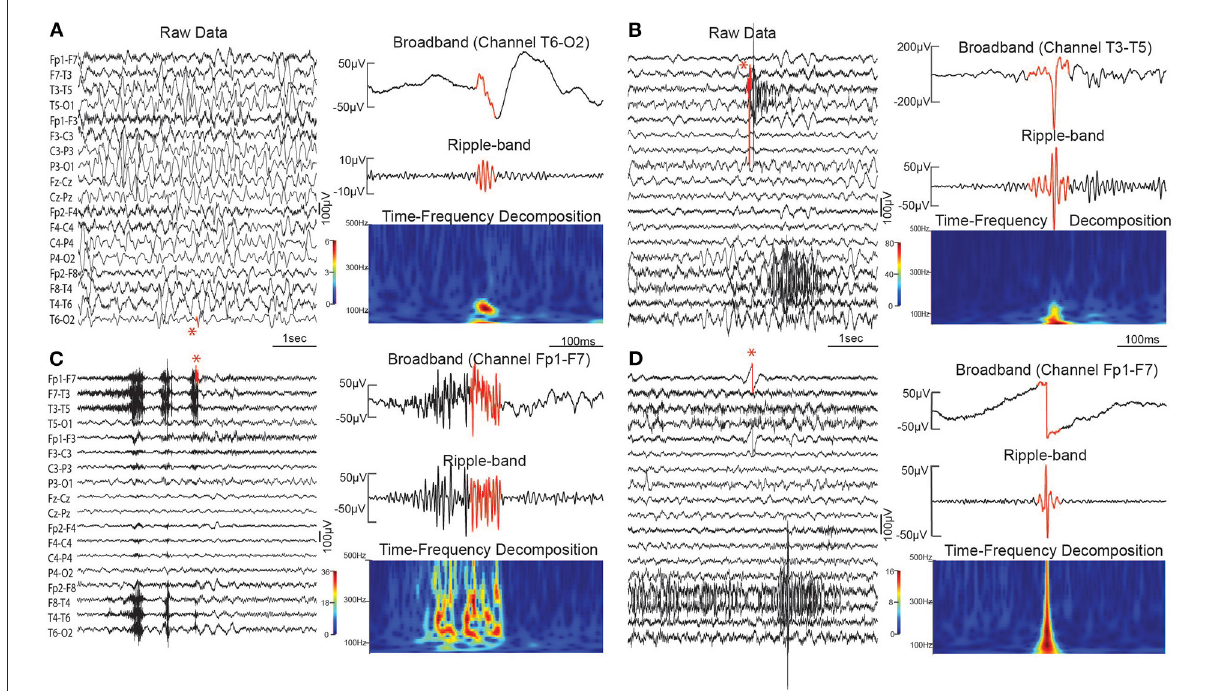
FIGURE4 Scalp HFO and artifact examples. (A) Scalp HFO in bipolar channel T6–O2 in a child with IS. (B) Sharp artifact in channel T3–T5. (C) Muscle artifact in Channel Fp1–F7. (D) DC shift artifact in Channel Fp1–F7. Sharp artifacts, muscle activity, and DC shifts can all cause false positive HFO detections. In each subfigure, 5s of broadband EEG is shown (left), with the red portion of the signal indicating the detected event (also marked by a red asterisk). On the right is the broadband EEG, with the detected event in red (top), the bandpass filtered EEG in the ripple frequency band (middle), and the time-frequency decomposition for the same segment of EEG